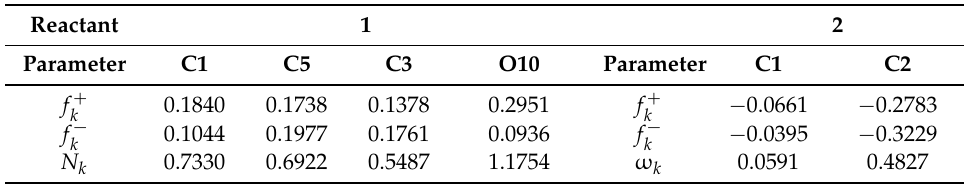
Table 2. Electrophilic and nucleophilic Fukui indices and local electrophilicities for the reactive atoms of 1 and 6 .